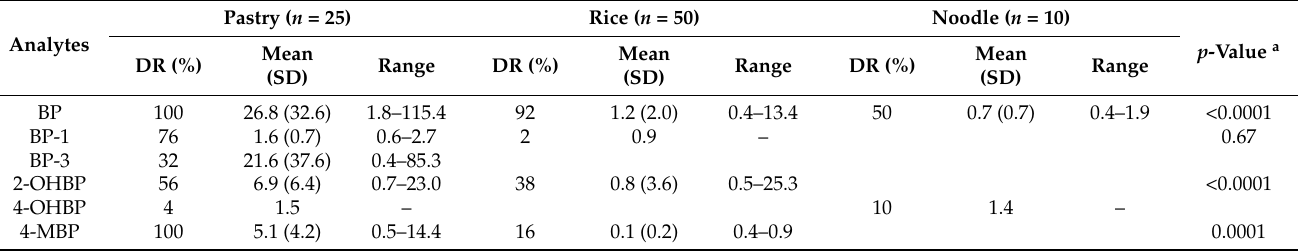
Table 7. BP and BPs levels in real samples (ng/g).